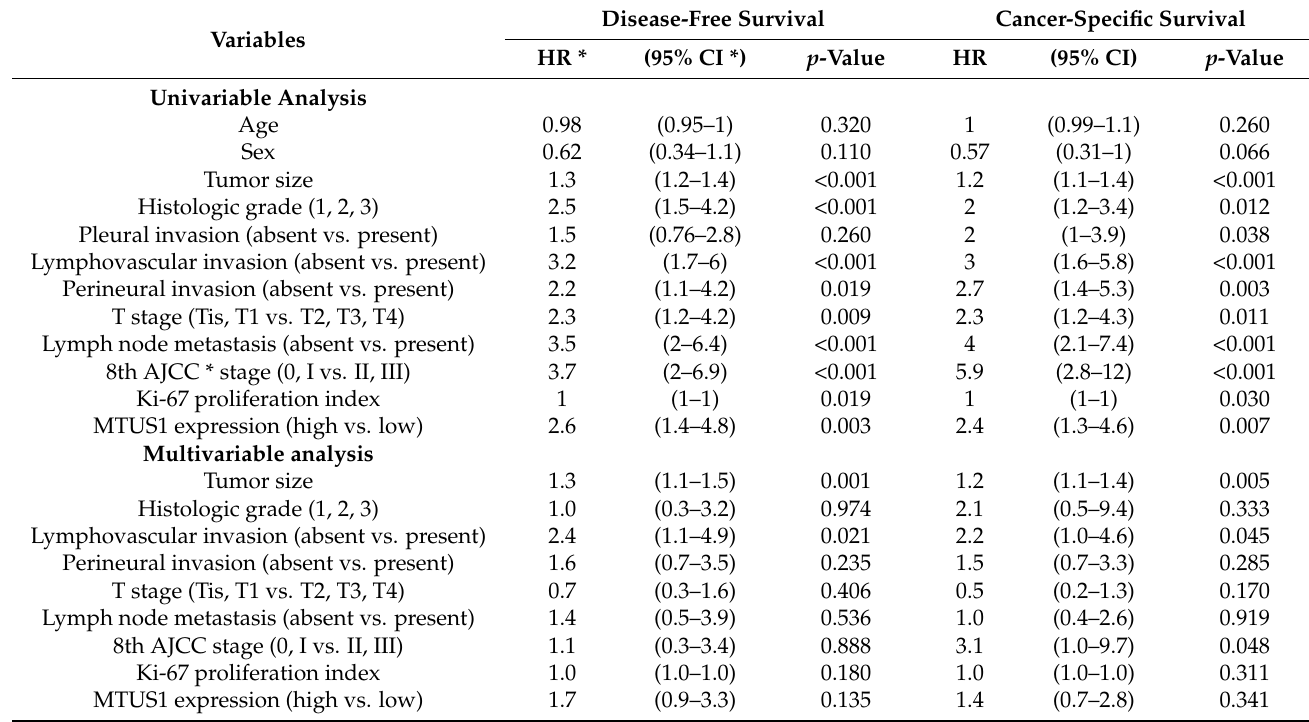
Table 3. Cox regression analysis of variables for predicting prognosis of lung